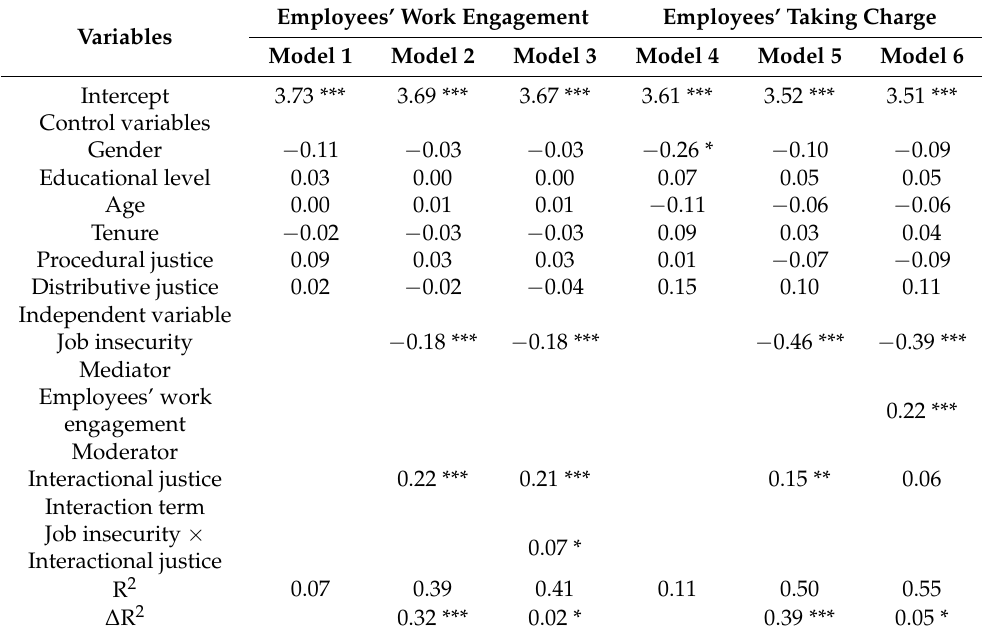
Table 2. The results of hierarchical regression analyses.